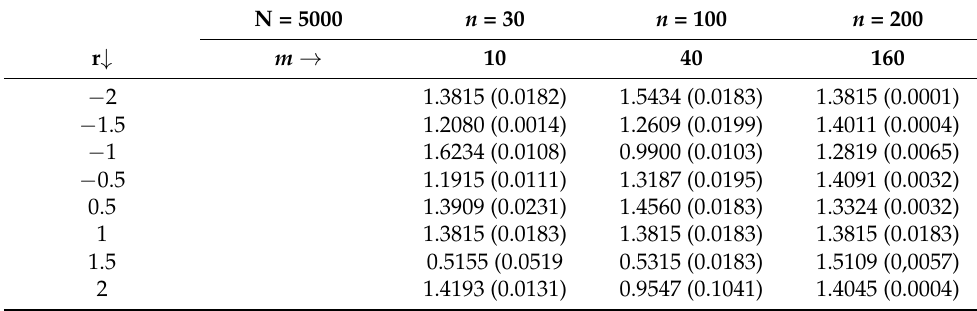
Table 9. Bayesian estimators and PR (in brackets) under Linex loss function.